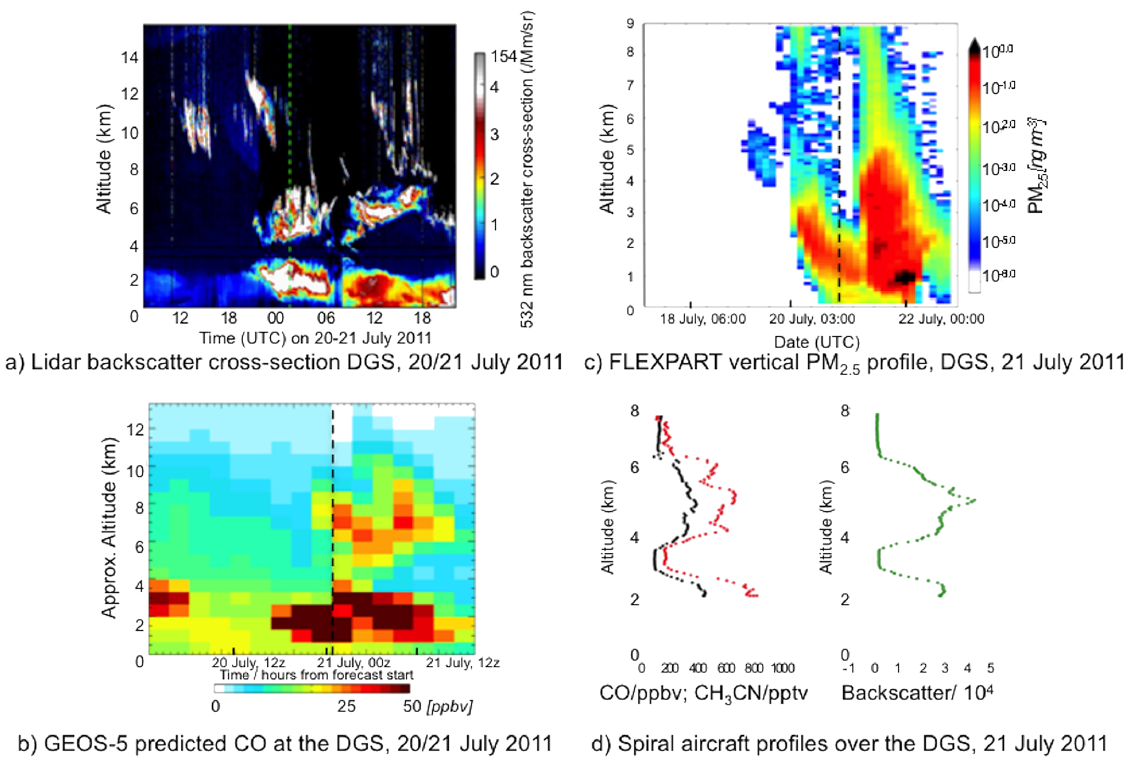
Figure 5. Comparison of simultaneous observations: (a) lidar backscatter cross section at DGS, 20/21 July 2011, (b) GEOS-5 CO forecast at DGS, 20/21 July 2011, (c) FLEXPART vertical PM 2 . 5 profile at DGS, 21 July 2011 and (d) spiral aircraft profiles over the DGS, 21 July 2011. Vertical dashed lines in (a) , (b) and (c) indicate the time of the spiral aircraft profiles in (d)